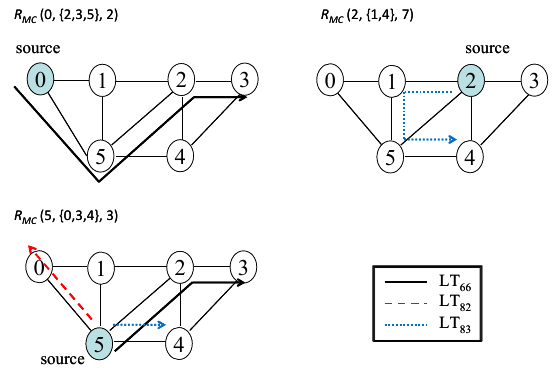
Fig. 9. The illustration of the optimal multicast routes for scenario 1